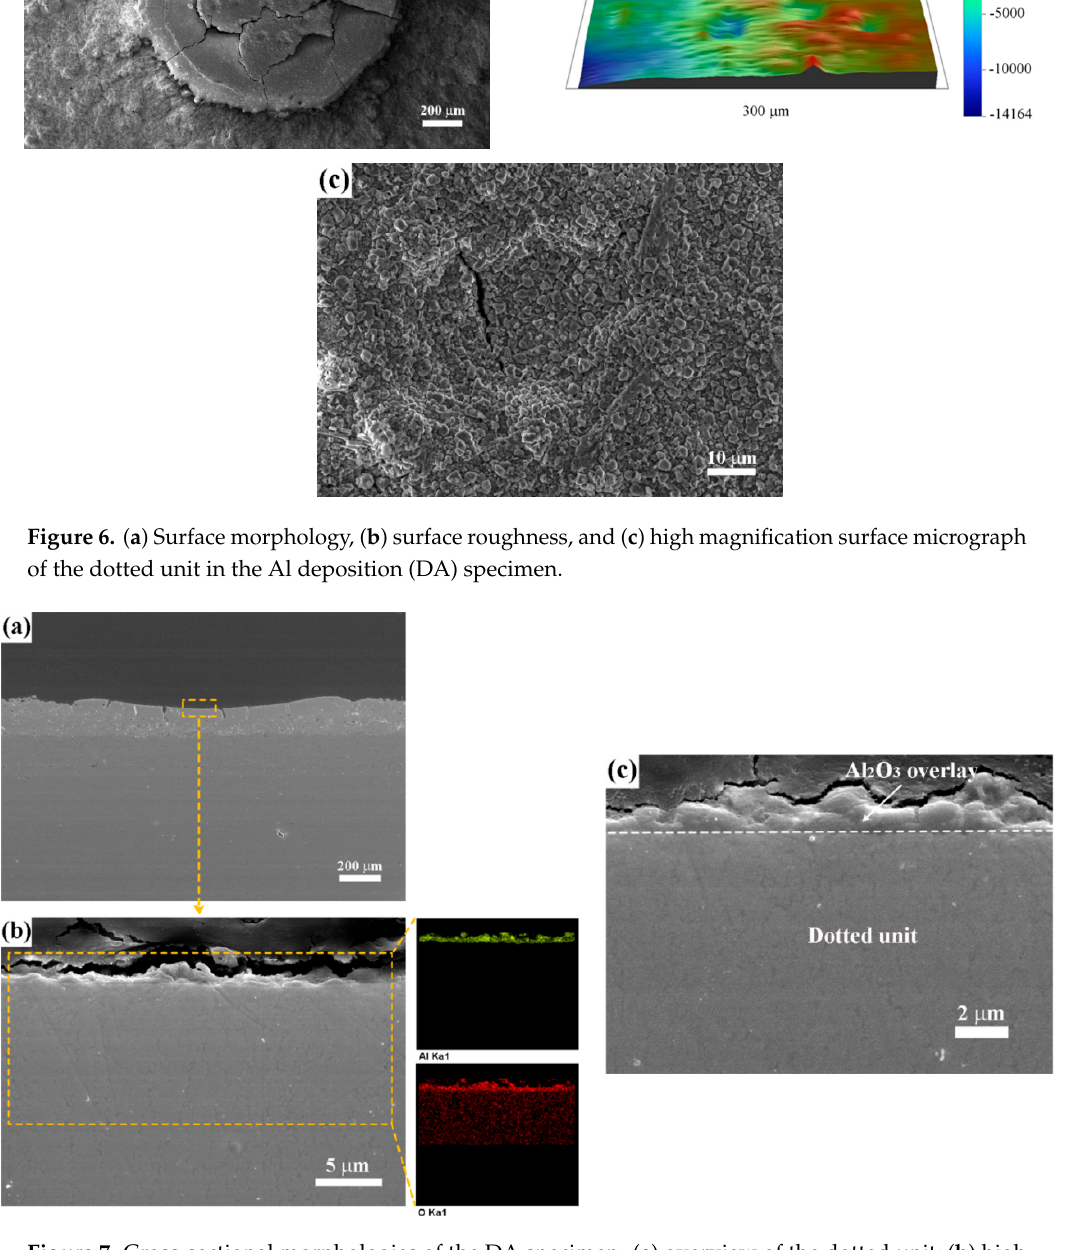
Figure 7. Cross-sectional morphologies of the DA specimen: ( a ) overview of the dotted unit; ( b ) high magnification micrograph of the dotted unit; and ( c ) high magnification micrograph of the overlay.